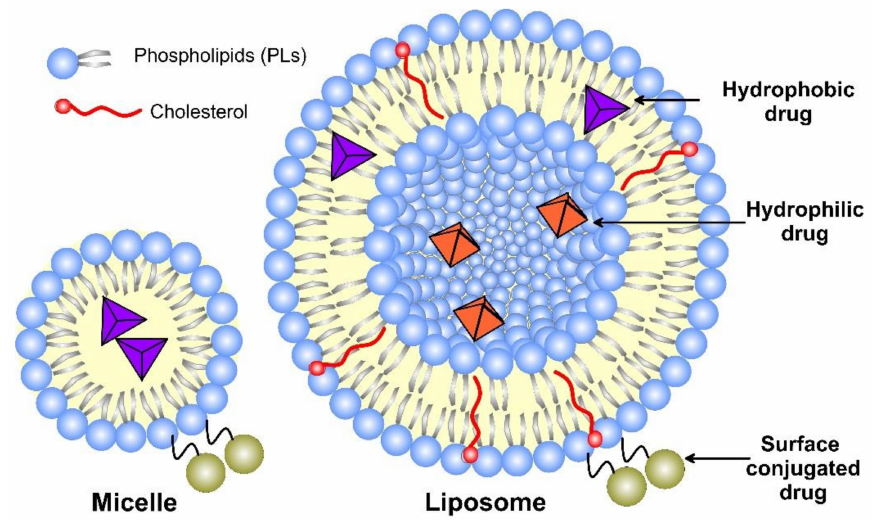
Figure 3. A schematic structure of micelle and unilamellar liposome, together with the possible drug